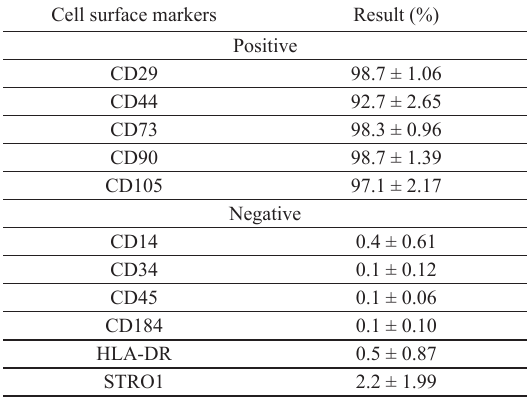
Table 6. Cell surface markers observed through flow cytometry analysis used for the identification of stem cells derived from adipose tissue and its percentage.